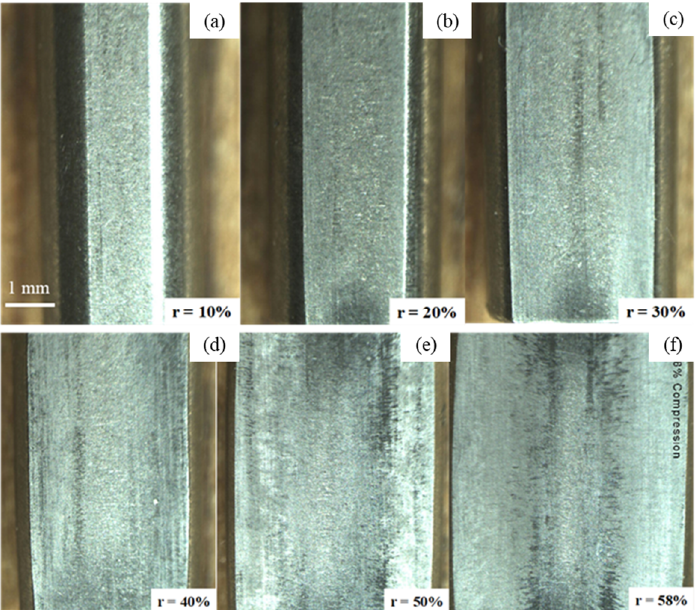
Figure 4. Upsetting forging behavior of β-titanium alloy wires with an increasing reduction in thickness with the use of Cs-SKD11 punch and β-SiC-coated SiC die. ( a ) r = 10%, ( b ) r = 20%, ( c ) r = 30%, ( d ) r = 40%, ( e ) r = 50%, ( f ) r = 58%.